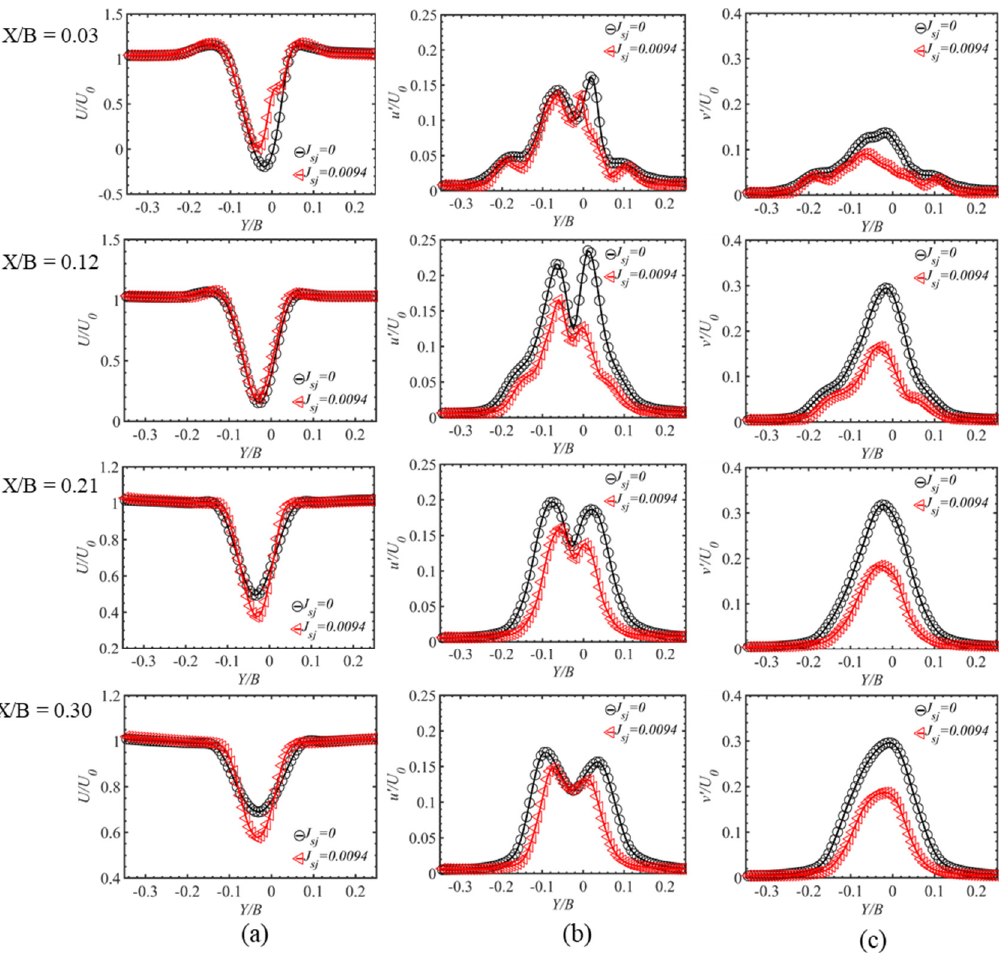
Figure 11. The velocity profile in the different locations at wake flow in measurement plane I. ( a ) Mean of the streamwise velocity, ( b ) fluctuation of the streamwise velocity, ( c ) fluctuation of the transverse velocity.